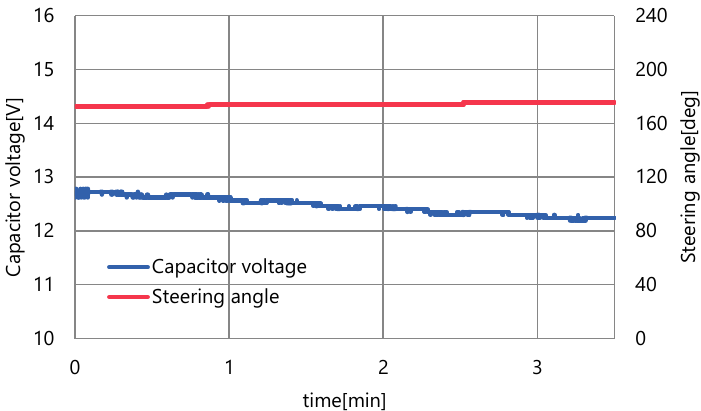
Figure 10. Capacitor voltage transition during backup power supply operation with steady circular turning (radius of 10